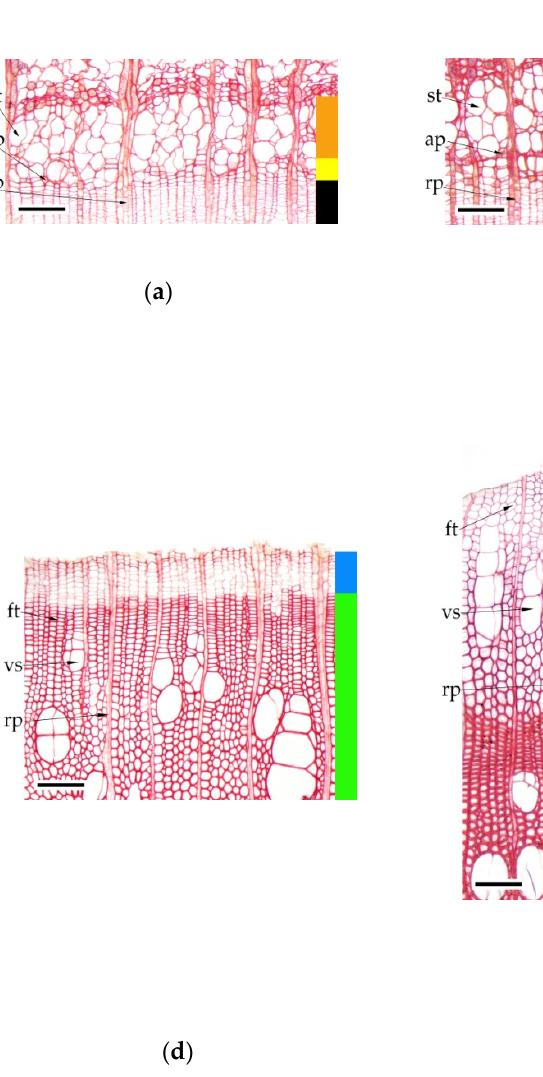
Figure 1. Transverse sections of phloem ( a – c ) and xylem ( d – f ) 35 cm above girdle (AG35) of girdled trees. ( a , d ) 10 days after girdling (10DAG); ( b , e ) 20 days after girdling (20DAG); ( c , f ) 30 days after girdling (30DAG). Colors show the following tissue layers. Green: xylem formed before the experiment; blue: xylem formed after the experiment; black: cambial zone; yellow: late phloem; orange: early phloem. The letters in the figures are vs: vessels; ft: fibrous tracheids; rp: ray parenchyma; ap: axial parenchyma; st: sieve tubes. Scale bar is 100 µm. In the AG1 level of the girdled trees, xylogenesis ceased immediately after girdling. Deposition of new xylem elements by the cambium was observed, for the first time, only at 30DAG. Active phloem formation, comprising small sieve tubes and parenchyma cells, was observed immediately after girdling. At 30DAG, we observed groups of sclereids that were absent in the 20DAG samples. The sclereids were larger than the surrounding parenchyma cells and had thickened lignified cell walls (Figure 2).